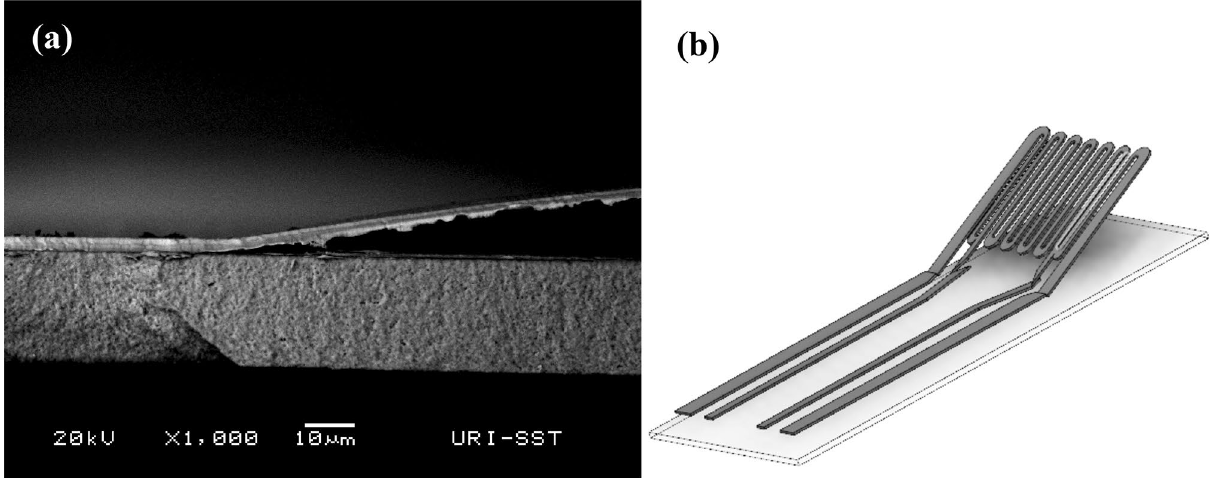
Figure 6. SEM micrograph of a free-standing Pd microheater after heat treatment at 500 °C ( a ). Schematic of the free-standing sensor showing delamination of the serpentine region of the microheater ( b ).